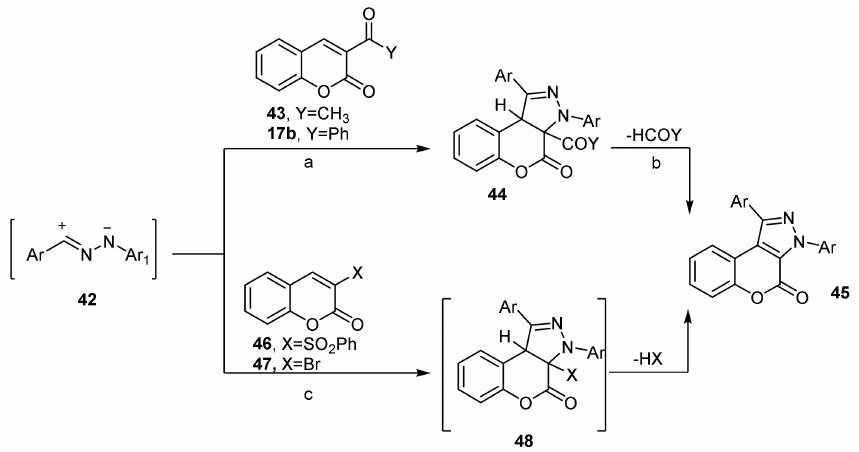
Scheme 13. The role of hydrazonyl halides in the preparation of chromeno[3,4- c ]pyrazol-4(2 H )-ones. Reagents and conditions. ( a ) Benzene, reflux, TEA, two outputs Y = CH 3 (51%), Y = Ph (48%); ( b ) i: KOH (10%), 12 h, reflux; ii: toluene, 2 h, reflux; ( c ) benzene, reflux, TEA, two outputs Ar = C 6 H 4 F- p ,